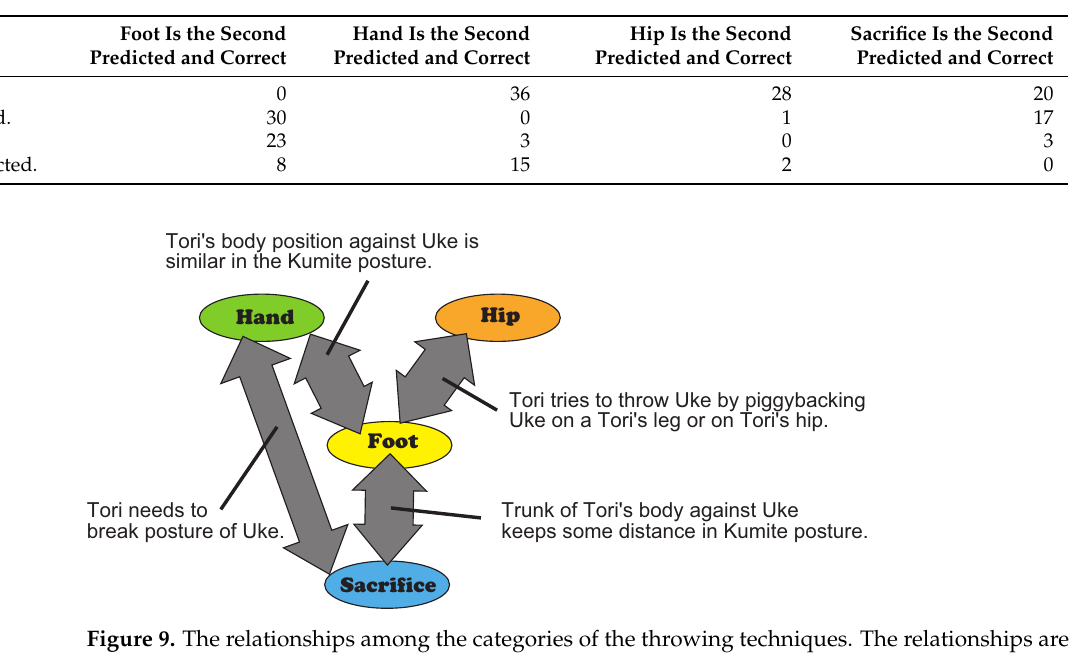
Figure 9. The relationships among the categories of the throwing techniques. The relationships are derived from the total numbers of the first and the second predicted